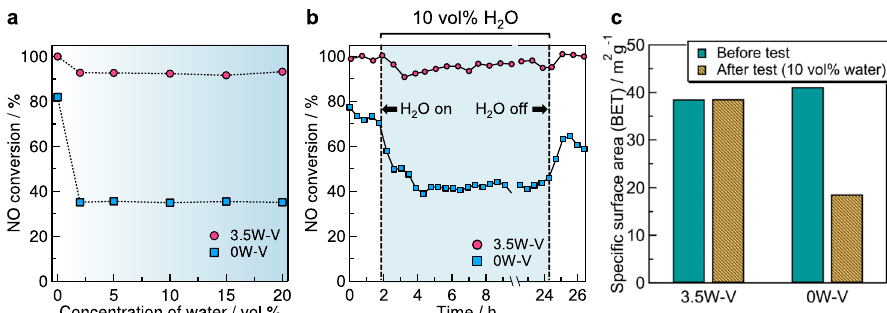
Fig. 4 Water tolerance of W-substituted vanadium oxide catalysts. a NO conversion (150 °C) of 3.5W – V (W-substituted vanadium oxide) and 0W – V (without tungsten) as a function of the concentration of water. b Catalytic stability test (150 °C) of 3.5W – V and 0W – V. Reaction conditions: the amount of the catalyst, 0.375 g; reaction gas mixture, 250 ppm NO, 250 ppm NH 3 , 4 vol% O 2 and 2 – 20 vol% H 2 O (when used) in Ar; fl ow rate, 250 mL min − 1 ;